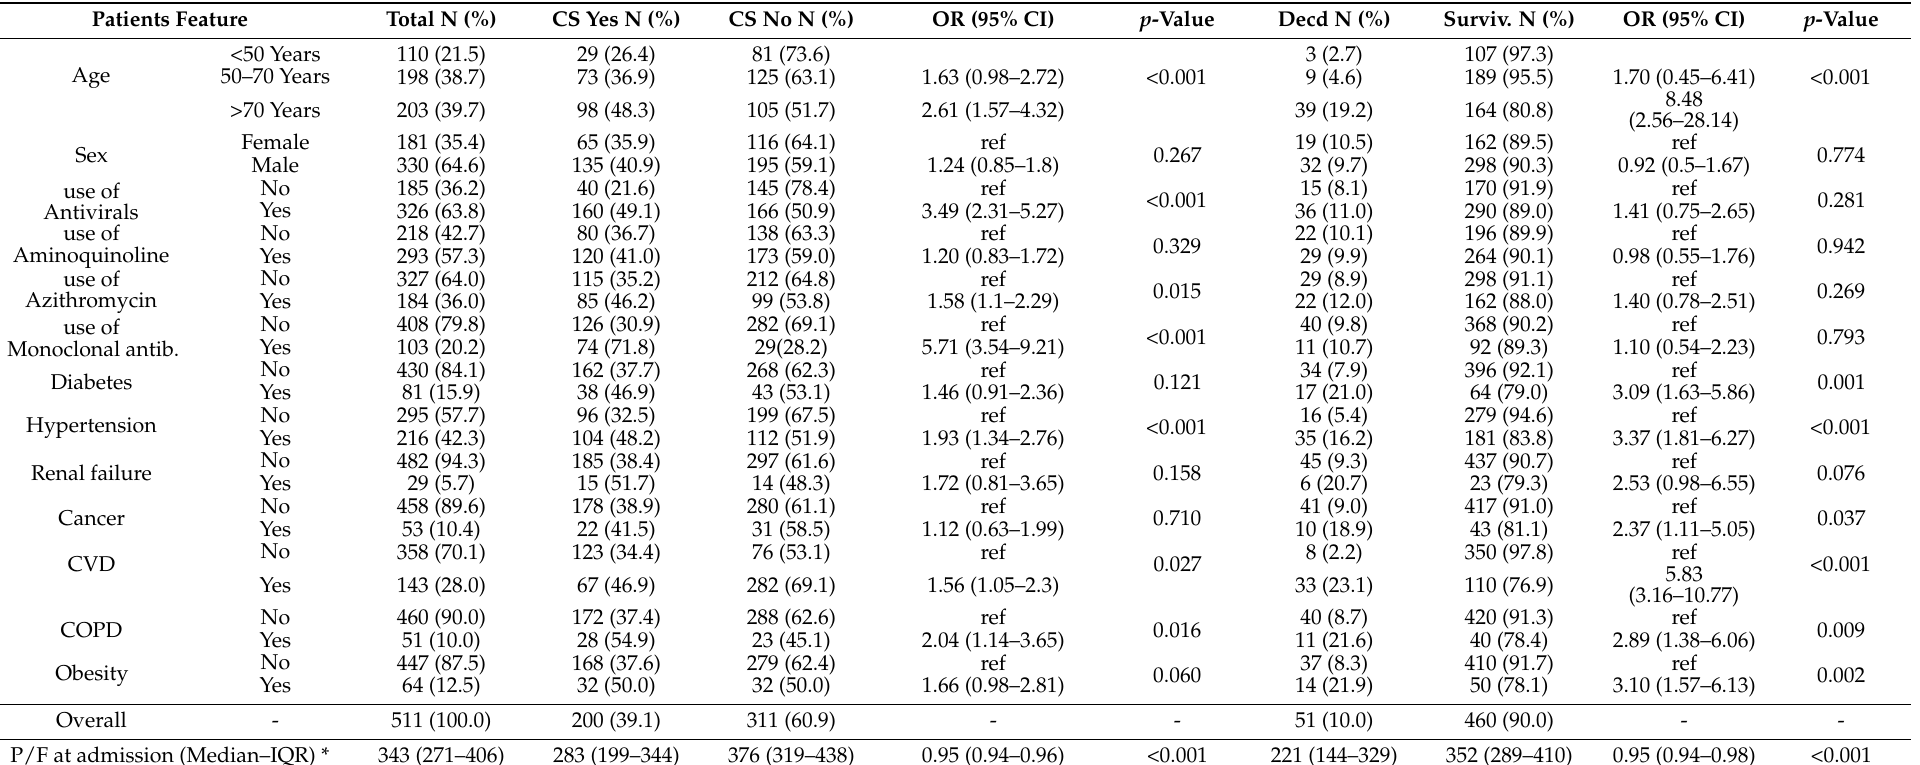
Table 1. Patients’ demographic, co-morbidities, and univariate analysis results with respect to steroid therapy and death within 28